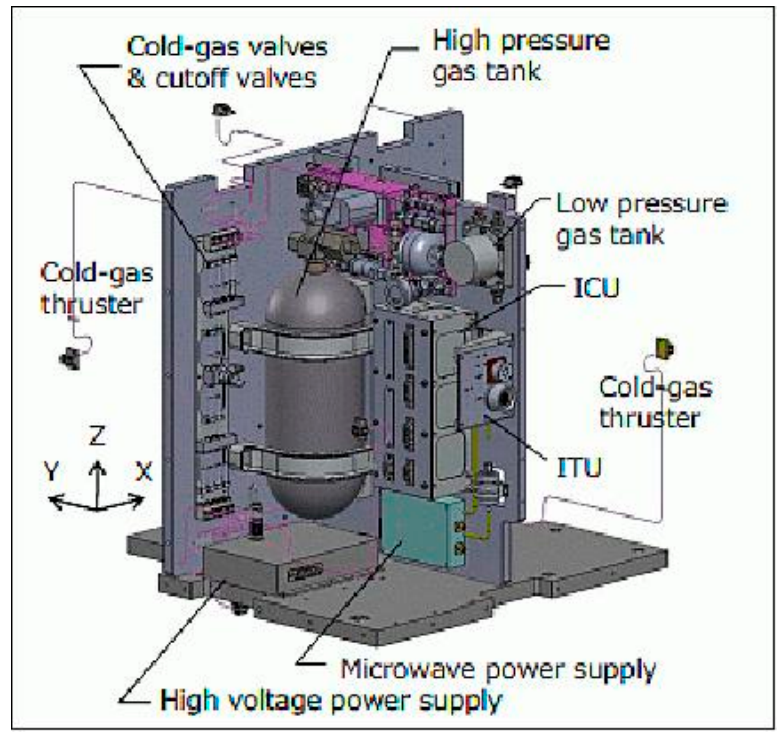
Figure 14. Cold Gas Thruster (eoPortal Directory, 2002) [33].